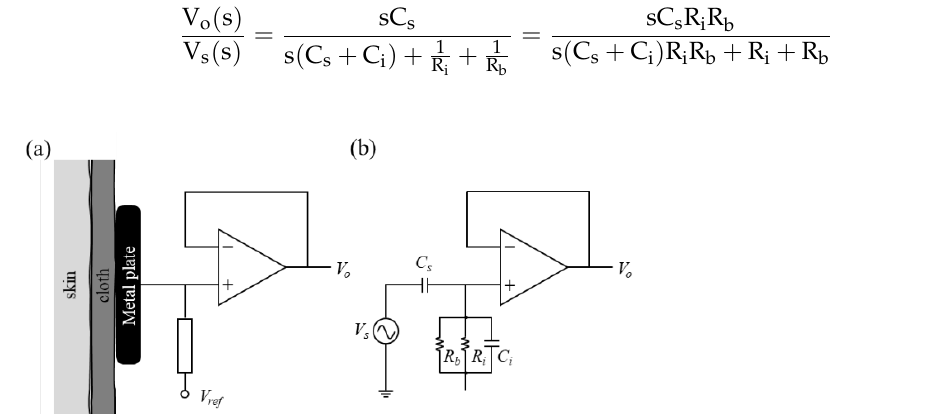
Figure 2. ( a ) Basic structure and ( b ) equivalent electrical circuit of noncontact electrode.